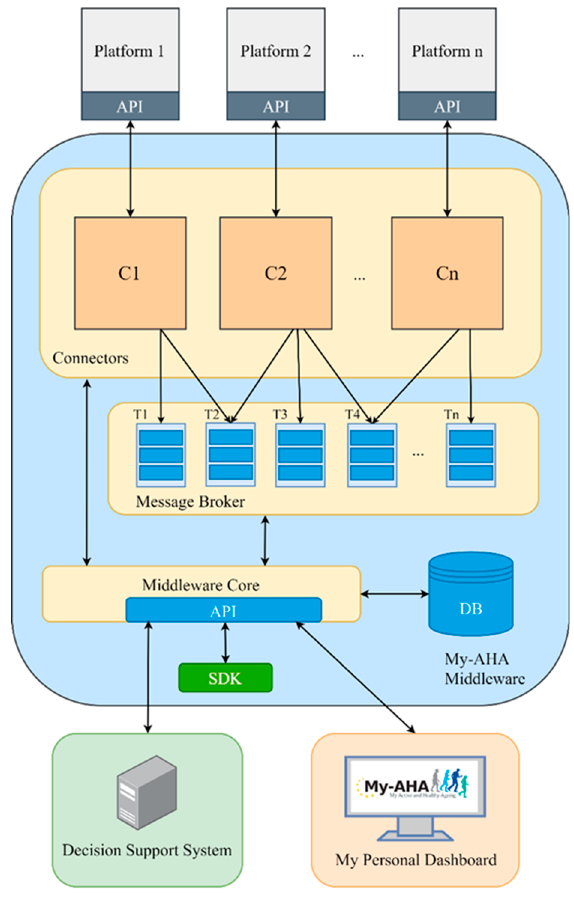
Figure 1. High-level overview of the My-AHA software platform.